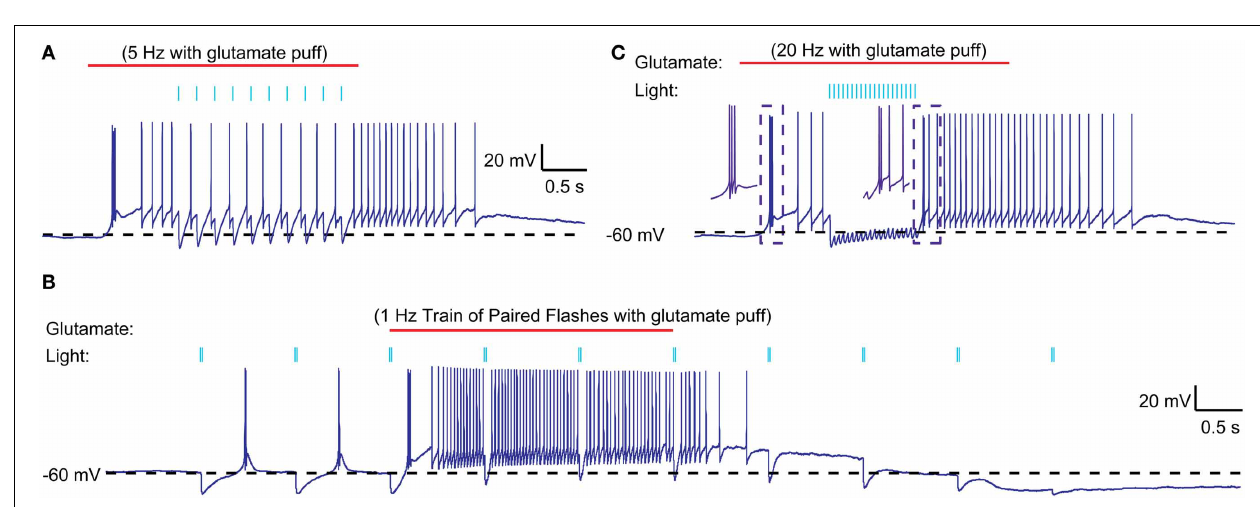
consistently resulted in LTS bursts in a VM neuron. Five different trials are overlaid to illustrate the trial-to-trial variability in the LTS latency. (B) Same neuron. Paired pulses (2ms pulses, 20ms interval) elicited LTS rebounds for some paired stimuli. These LTS rebounds consisted of 1–3 spikes.